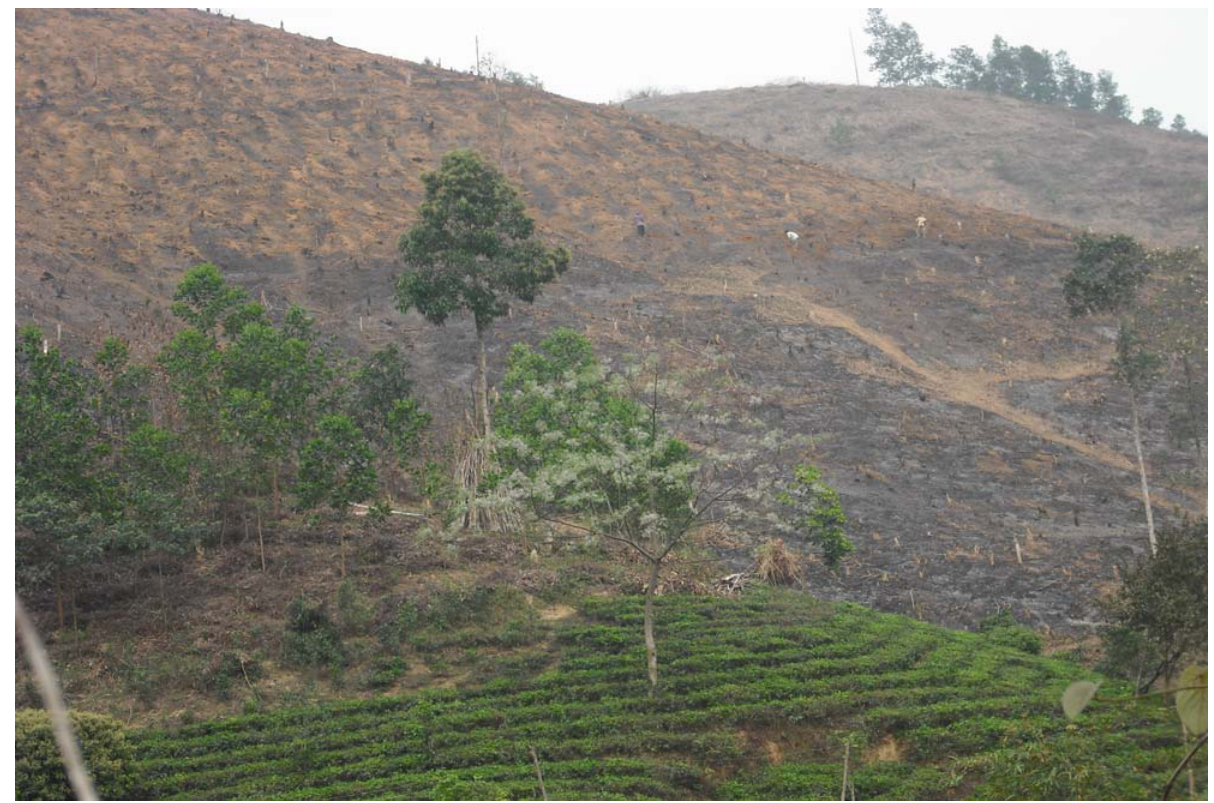
Figure 2. Forest clearing for agricultural use in the TDNP region (Photo by author,